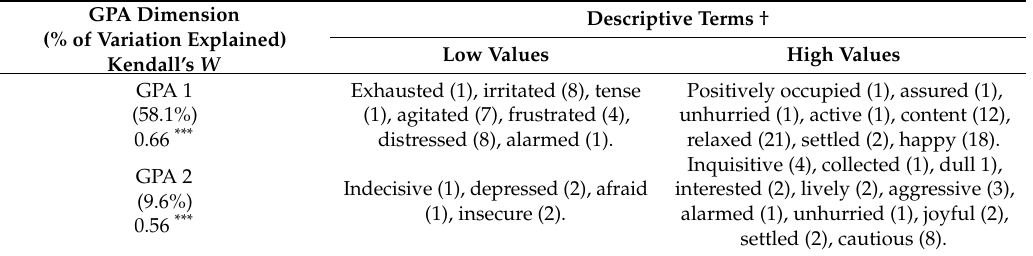
Table 4. Terms used by observers using the Free-choice Profiling (FCP) method of Qualitative Behavioural Assessment (QBA) to describe the behavioural expression of sheep filmed in